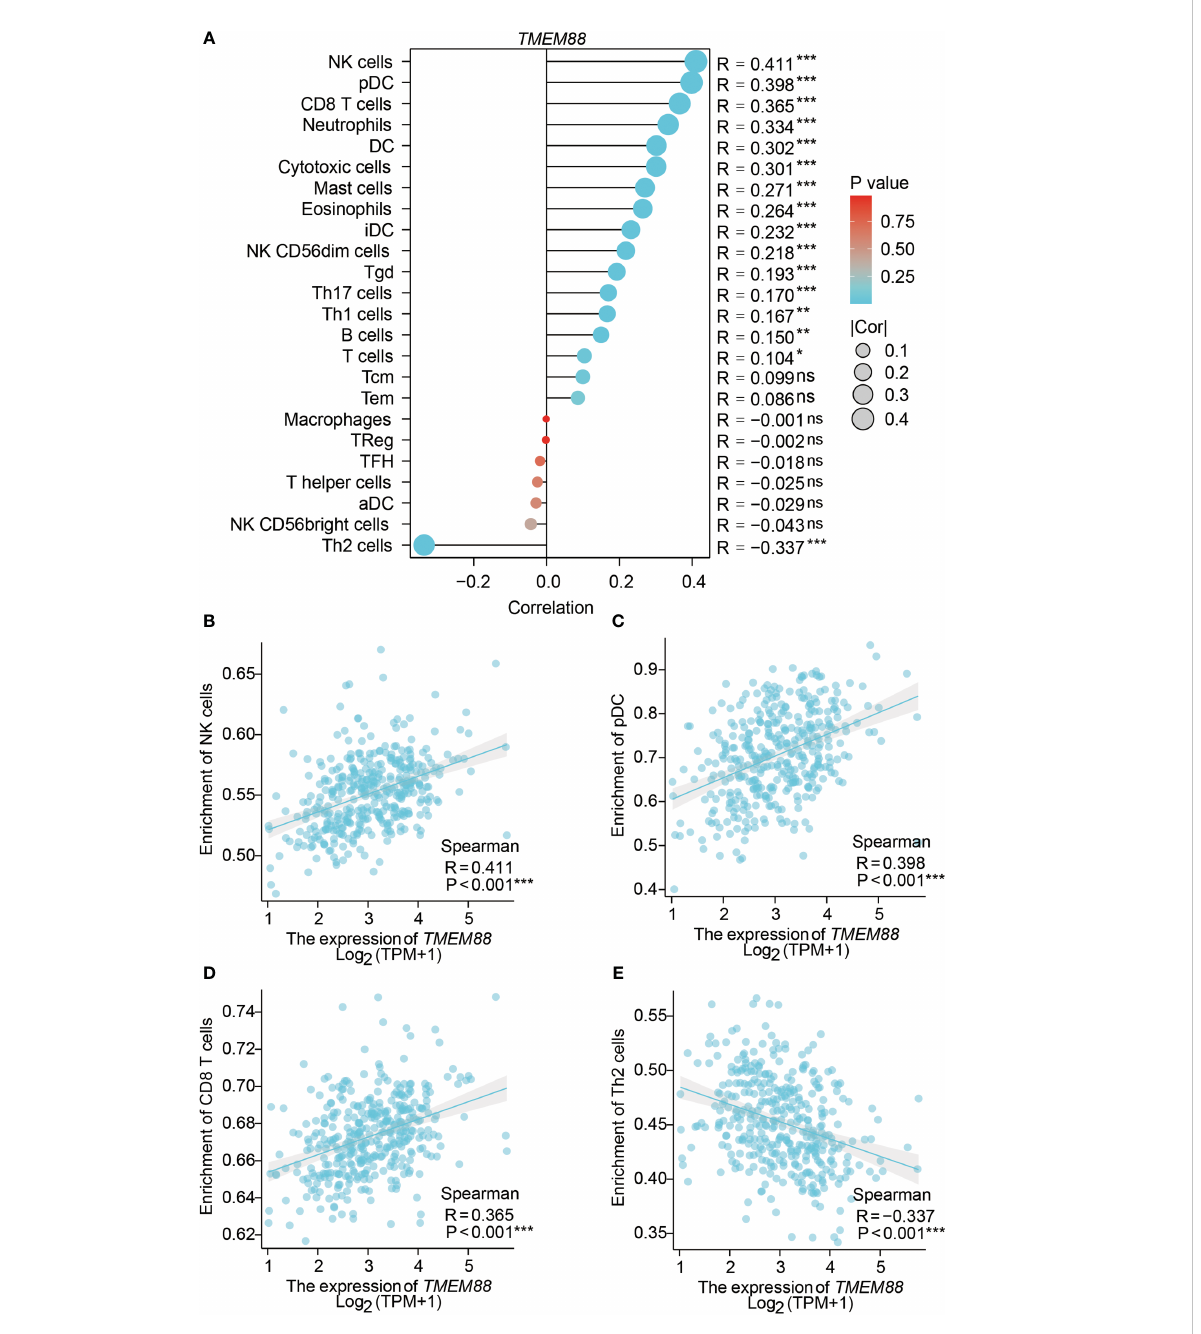
FIGURE 5 TMEM88 was correlated with immune cell enrichment in HCC microenvironment. (A) The correlations between immune cell enrichment and TMEM88-mRNA level in HCC tissues were summarized. Spearman correlation tests indicated positive correlations between TMEM88-mRNA level and NK cell enrichment (B) , pDC cell enrichment (C) , CD8+ T cell enrichment (D) . In contrast, TMEM88 level was negatively correlated with Th2 cell enrichment (E) . *P<0.05, **P<0.01,***P<0.001, ns, not signi fi